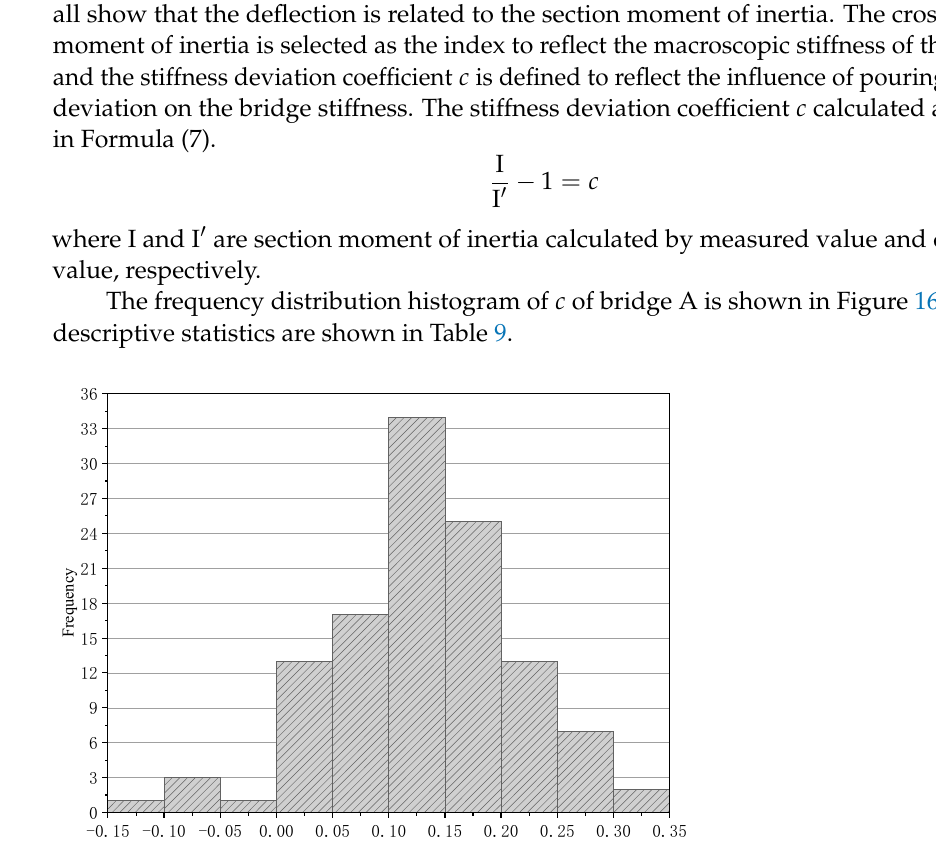
Figure 16. Frequency histogram of c of bridge A. Table 9. Statistically analysis of c of bridge